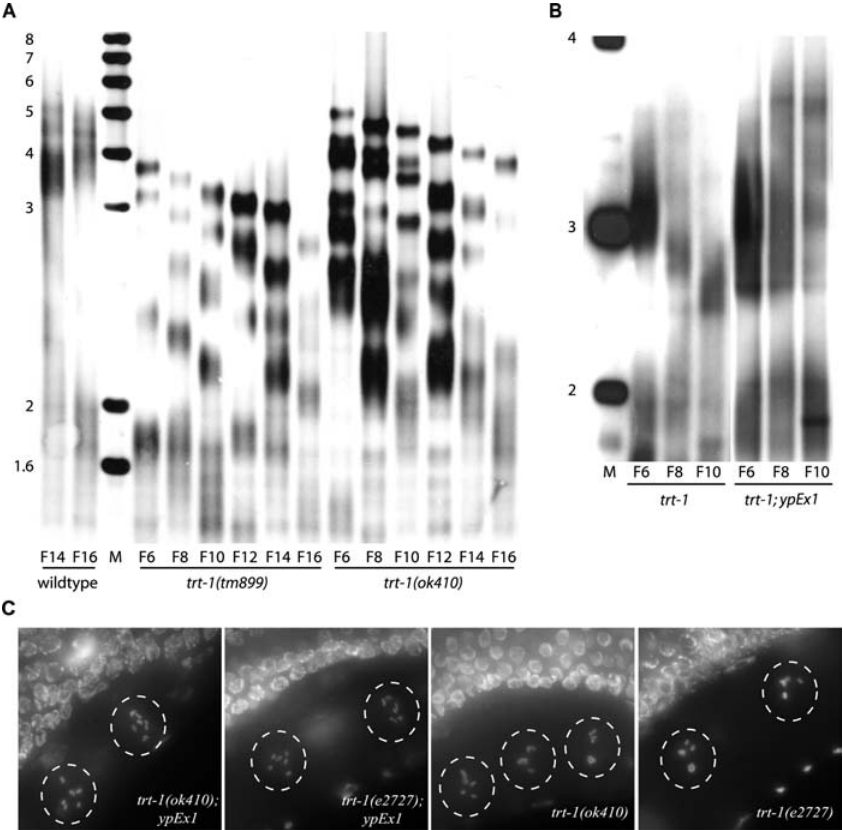
Figure 2. Progressive Telomere Shortening in trt-1 Mutants and Rescue by the Wild-Type DY3.4 Gene (A) The trt-1 alleles tm899 and ok410 displayed comparable rates of telomere shortening over progressive generations. Two generations of N2 wild-type are shown for comparison. Southern blotting was performed using a (TTAGGC) n probe and genomic DNA prepared from propagated strains as described [12]. (B and C) Expression of DY3.4 on the ypEx1 extrachromosomal array (B) eliminated telomere shortening for trt-1(ok410) in comparison with a nonrescued control and (C) repressed the formation of chromosome fusions observed in late-generation ok410 and e2727 mutants. Adult animals were stained with DAPI at generation F10, where nonrescued siblings exhibited a strongly reduced brood size or sterility. For Southern blots, sizes of DNA fragments are indicated to the left (kb). DOI: